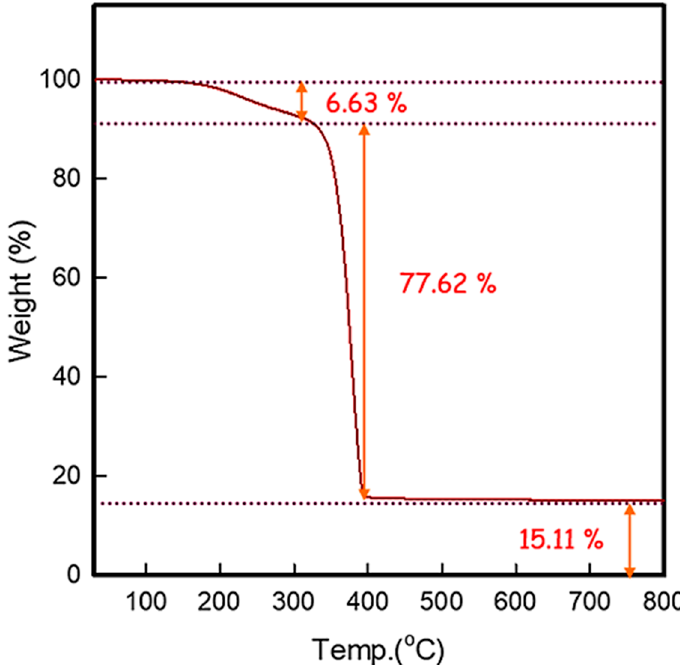
Figure 9. Thermogravimetric analysis curves of poly(lactic acid)–graphene filament for 3D printing [109]. Reproduced with permission from Springer.